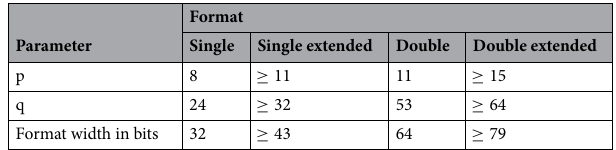
Table 3. Summary of format parameters.